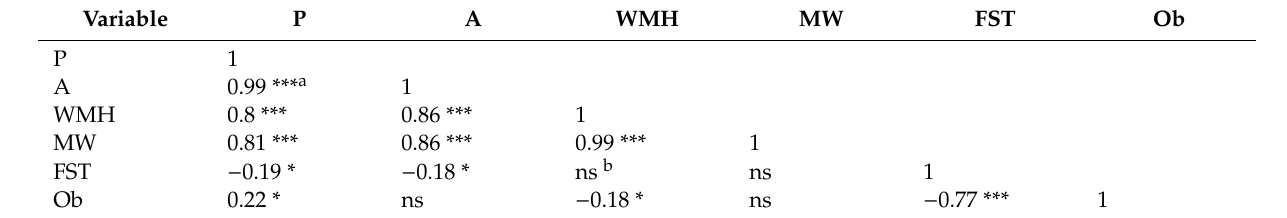
Table 2. Pearson’s correlation coe ffi cient among fruit morphology traits in the intra-specific tomato population NC 10204 in F 2:3 generation. Variable P A WMH